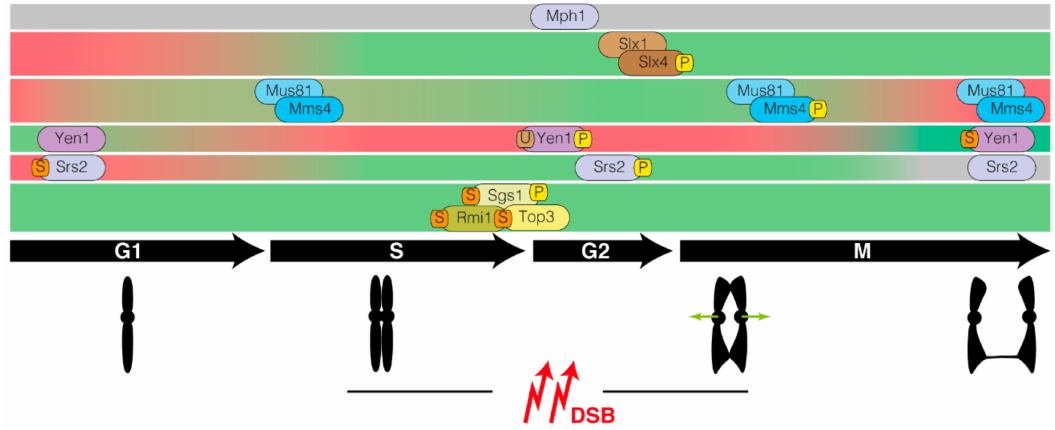
Figure 2. Temporal regulation of DNA-processing complexes involved in the removal of recombinant structures in the mitotic cycle. The diagraph represents the temporal activation (green bars) and inactivation (red bars) of each complex along the cell cycle. Regulation of distinctive enzymatic activities by phosphorylation (P), SUMOylation (S) and ubiquitylation (U) is depicted. Grey bar indicates that the mechanistic details of the temporal regulation are still